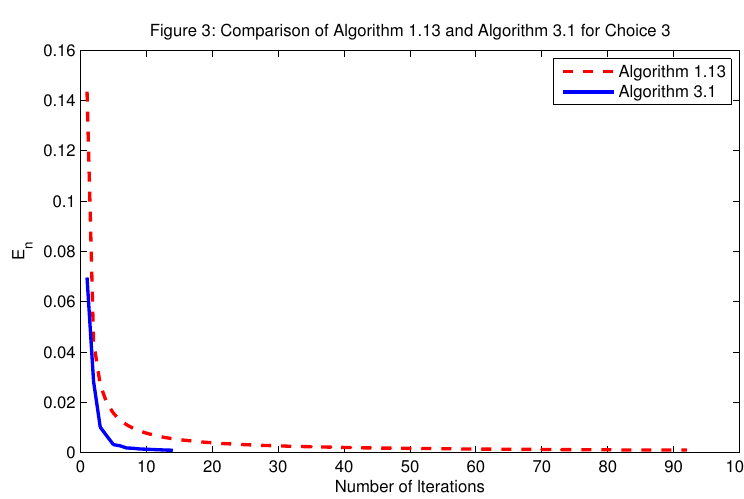
Figure 3. Comparison of Equations (13) and (25) for each choice 3.